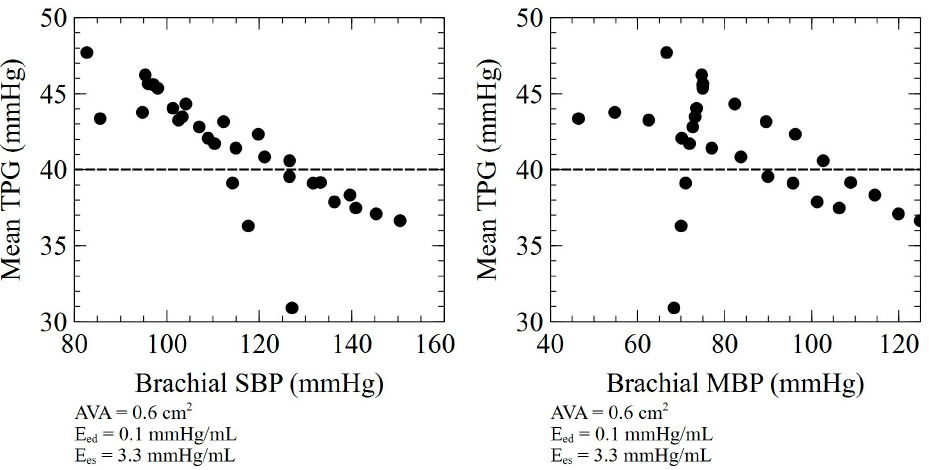
Figure 6. Association between peripheral blood pressure and mean TPG for cases presenting different combinations of TAC and TVR. SBP: Systolic blood pressure, MBP: Mean blood pressure.